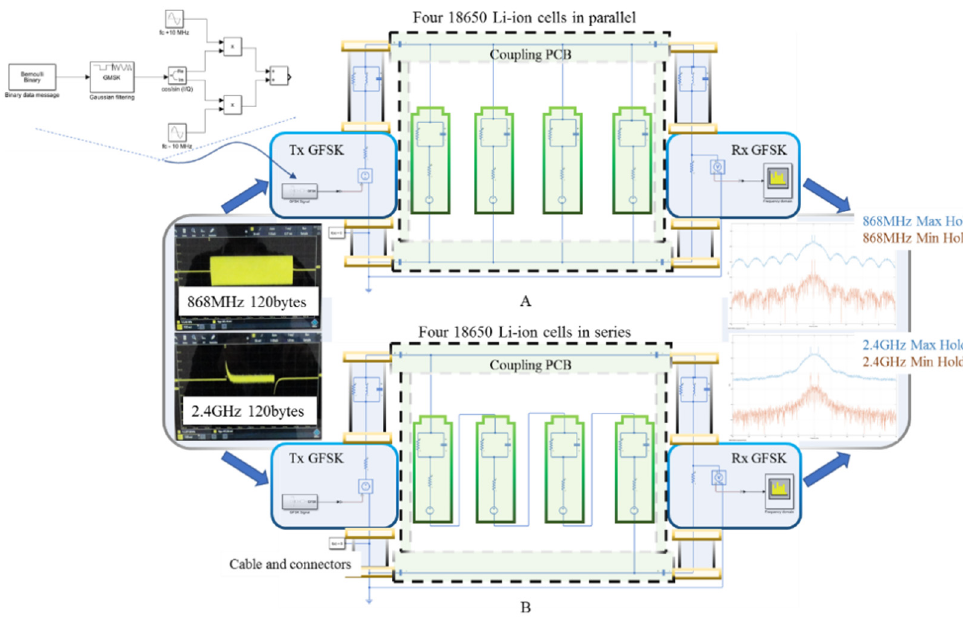
Figure 4. MATLAB Simscape test setup for 868 MHz and 2.4 GHz communication over the DC bus composed of four Li-ion cells organized in parallel ( A ) and series ( B ).